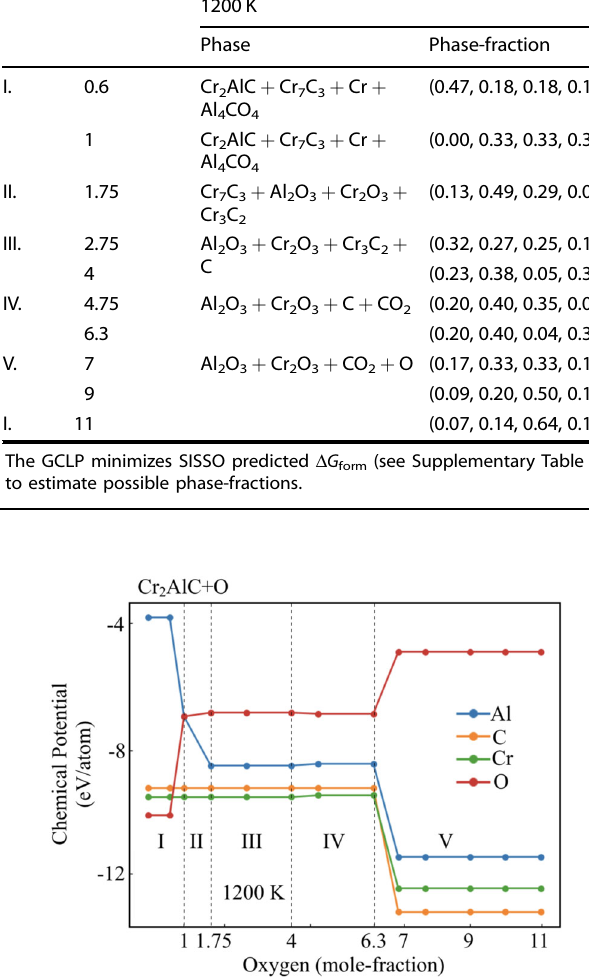
Table 3. Predicted set of thermodynamically favored reaction products in Cr 2 AlC + O 2 at reaction temperature of 1200 K. Stages Mole-oxygen Reaction products and phases-fractions [Ti 2 AlC + O 2